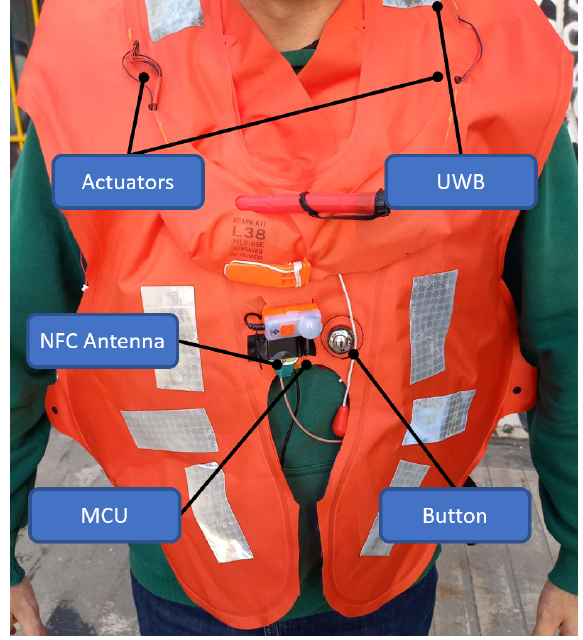
Figure 7. The lifejacket after the components have been